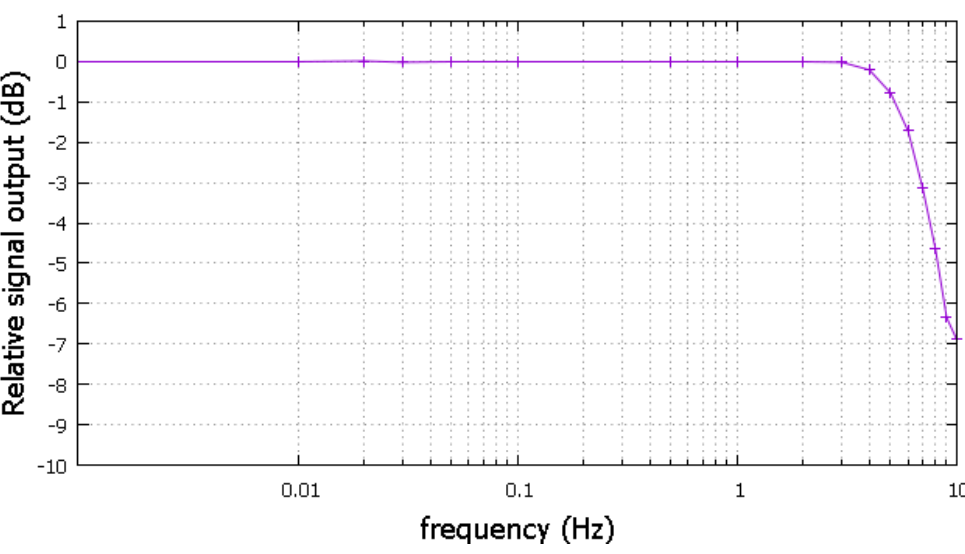
Figure 10. The sensor frequency